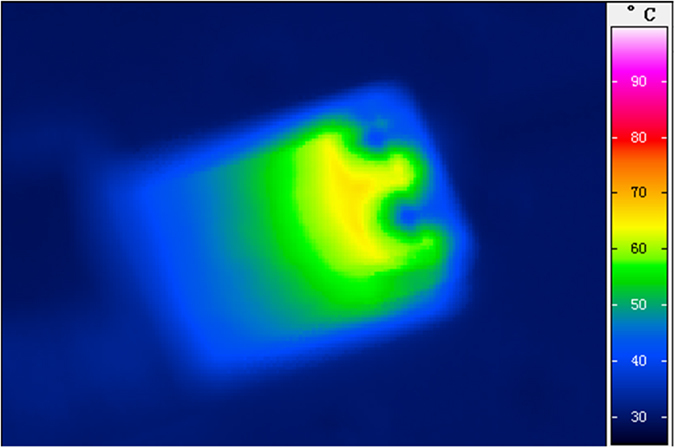
The PCB bottom surface thermal image of the 400-Gbps CDFP optical transceiver.